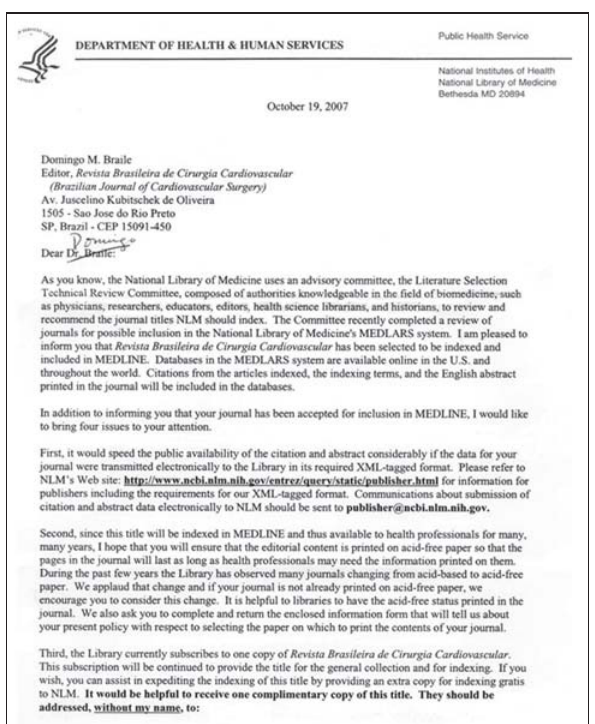
Fig.5 - Fac- Simile do Comunicado Original do